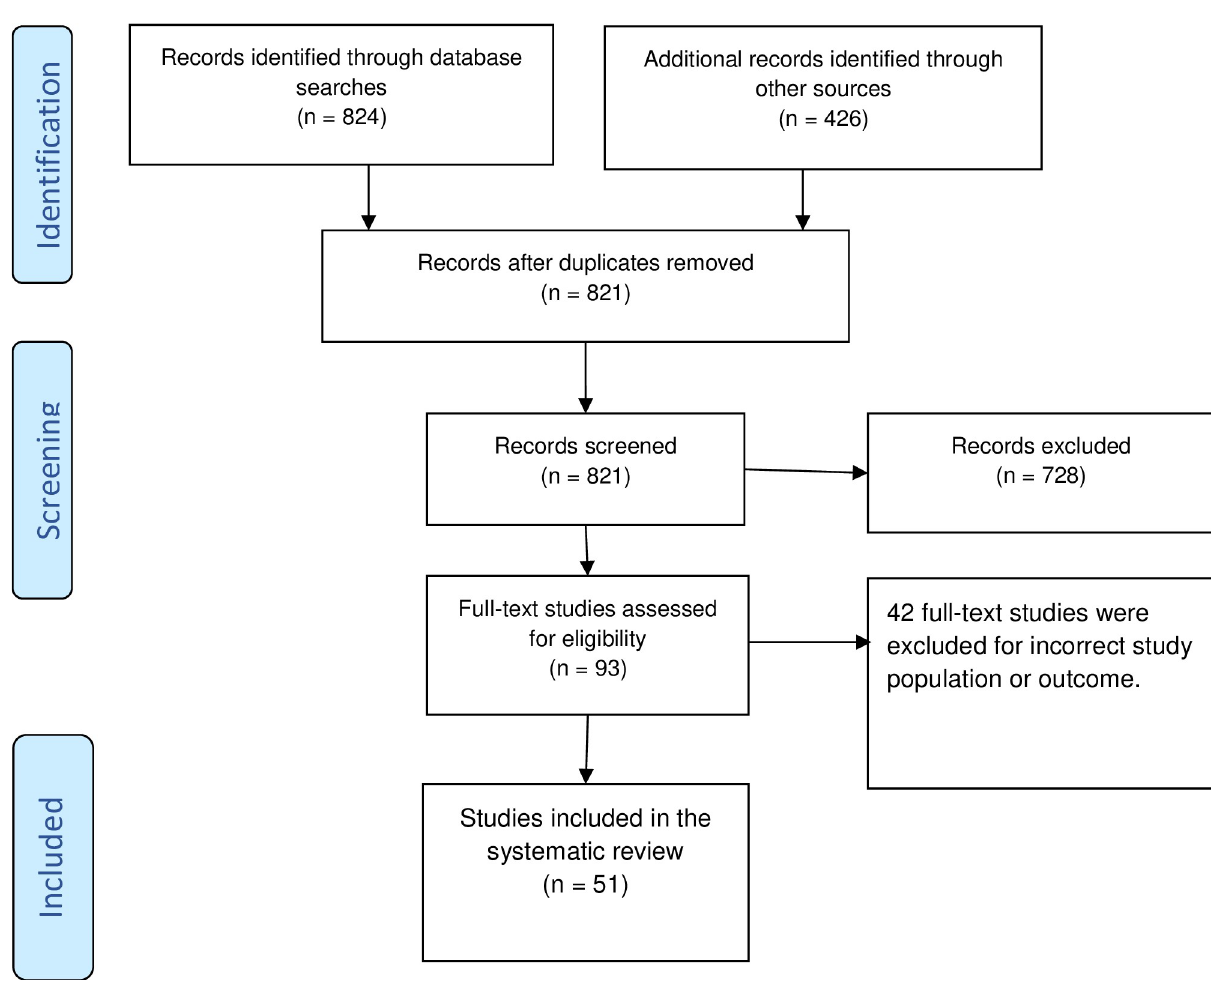
Fig 1. The Prisma flow diagram illustrating the study selection